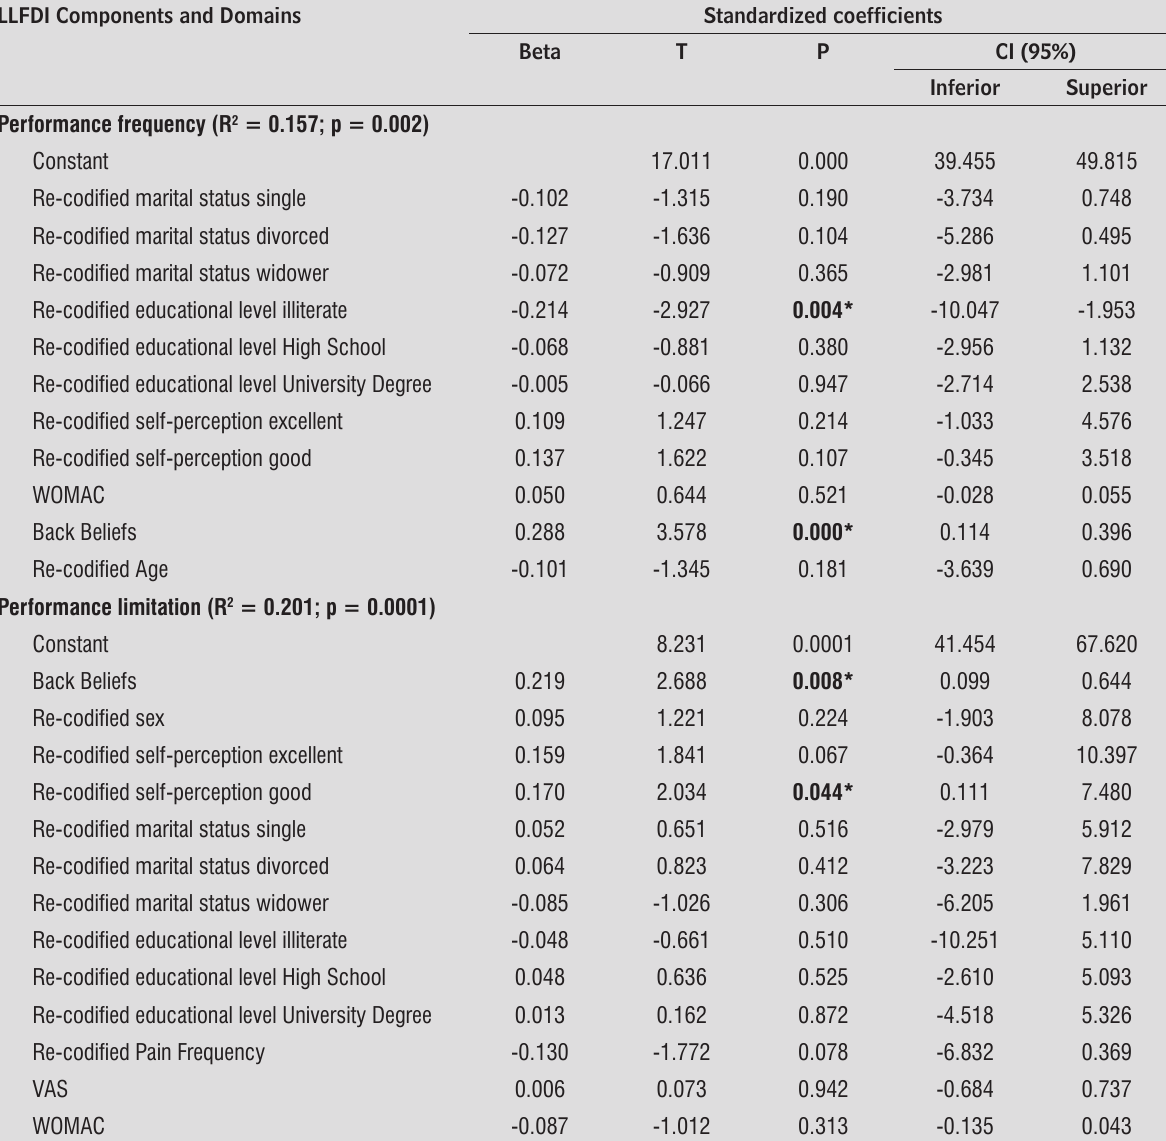
Table 4 - Multiple linear regression models of factors associated with LLFDI dimensions and areas LLFDI Components and